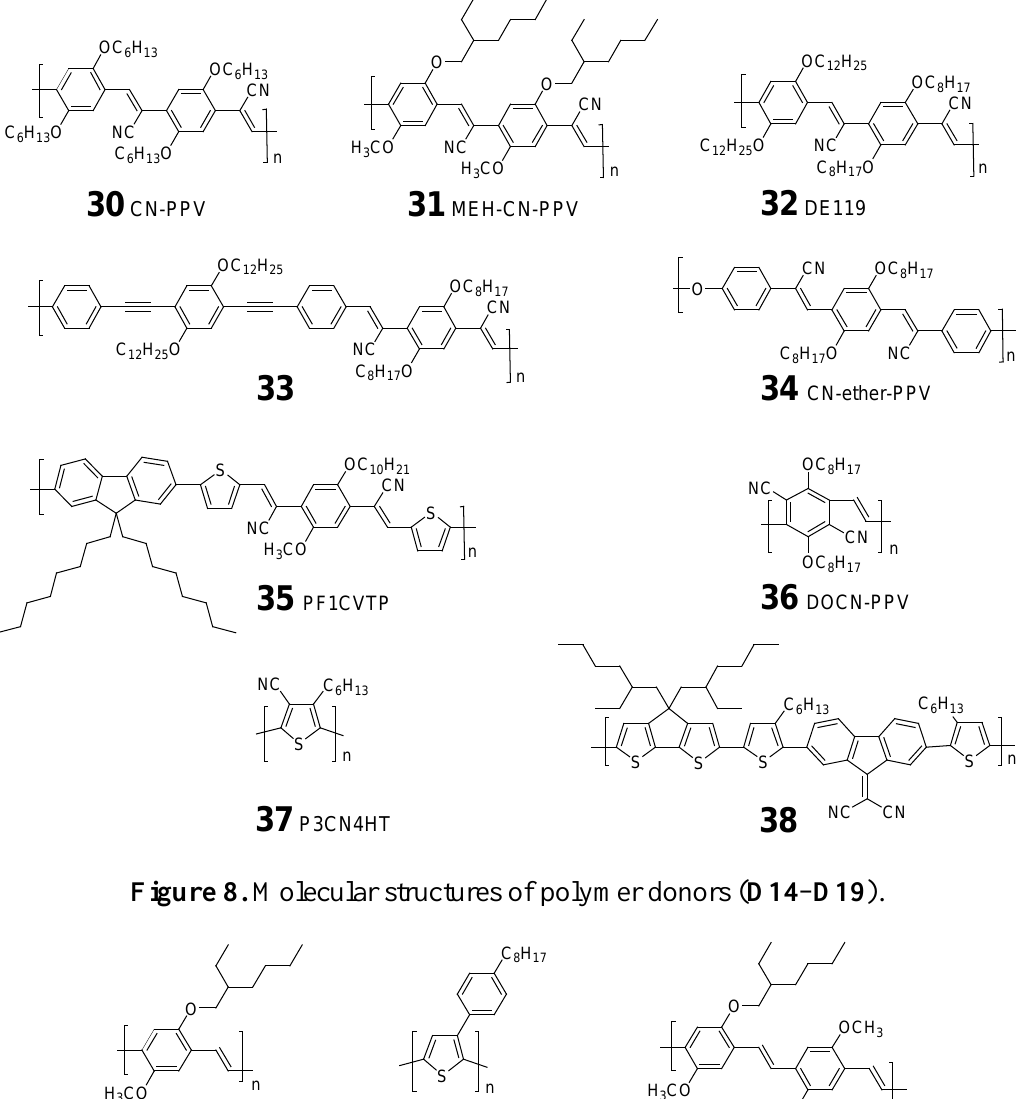
Figure 7. Molecular structures of CN-substituted polymer acceptors ( 30 – 38 ).